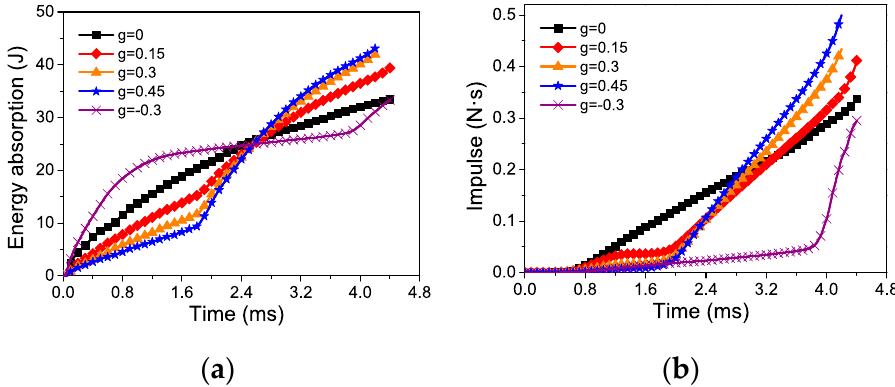
Figure 11. Gradient effects on two-layer graded aluminum foam under blast loading : ( a ) Energy absorbed; ( b ) impulse transmitted.